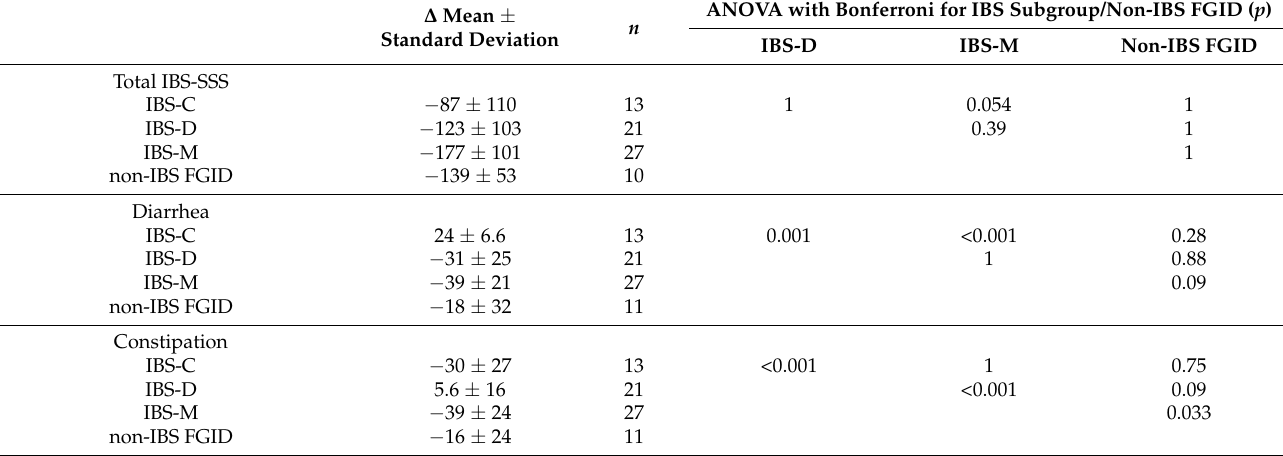
Table 5. GI symptom score changes ( ∆ ) and Post-hoc analyses of subgroups in the intervention group after the SSRD